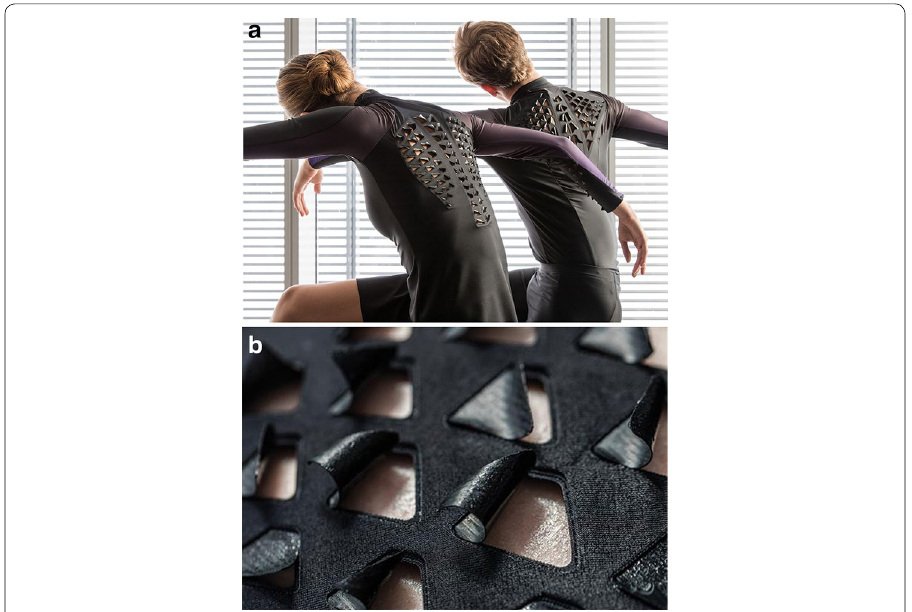
Fig. 8 a “Second Skin”. Photograph: Tangible Media Group/MIT Media Lab. b “Second Skin”